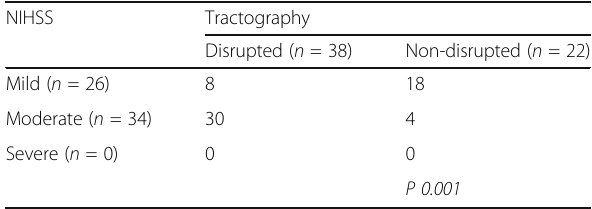
Table 2 Correlation between the tractography findings and NIHSS on admission